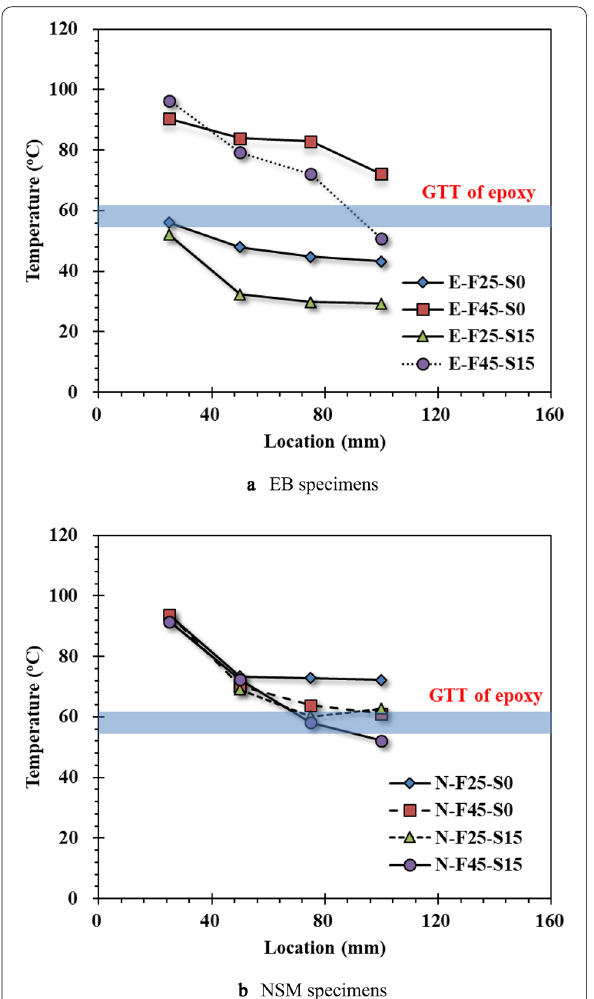
Fig. 17 Temperature profiles at each location when bond failure occurs.